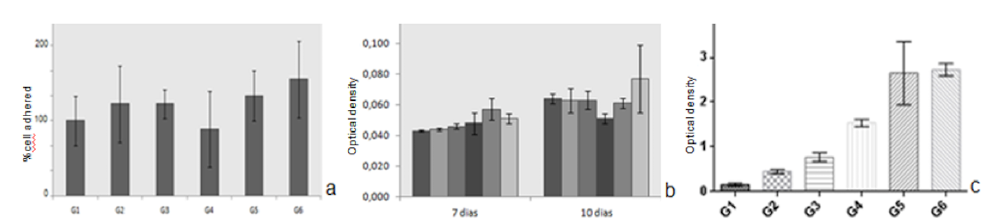
Figure 5. Effect of sample on cell adhesion (a), ALP (b), mineralized matrix (c).